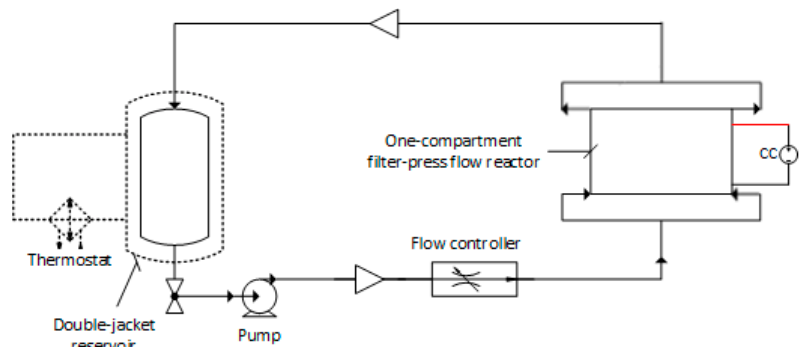
Figure 2. Flowchart of the electrochemical oxidation process (EOP) for organic removal from reverse osmosis concentrate (ROC). The red line is the anode contact. The dashed is the circulating external thermostated liquid (water/ethylene